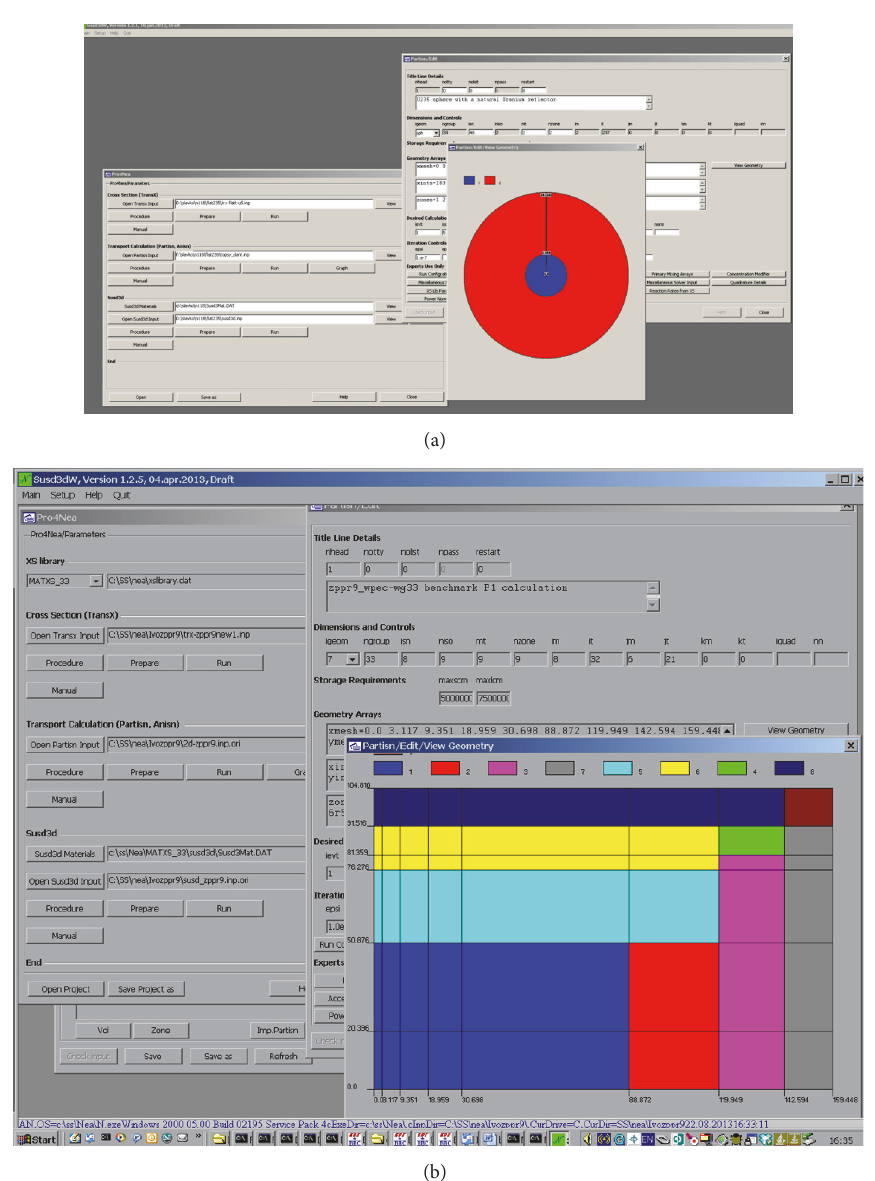
Figure 2: Screen captures of the PARTISN 1-dimensional (a) and 2-dimensional (b) test case running